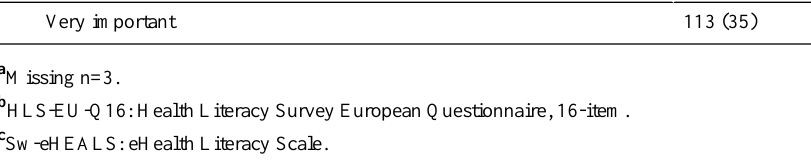
Table 3. Spearman rho correlations between the Sw-eHEALS sum score and demographic characteristics, questions, and questionnaires.